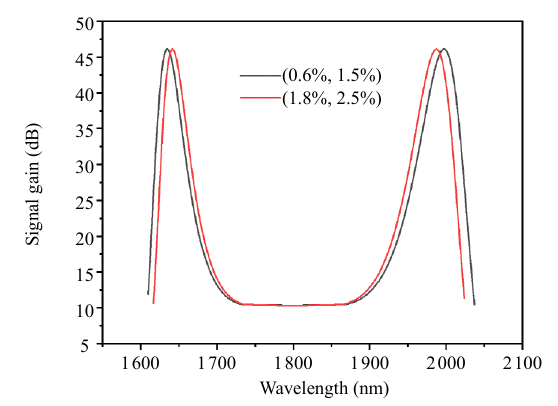
Fig. 11 FWM gain spectra of the initial and final